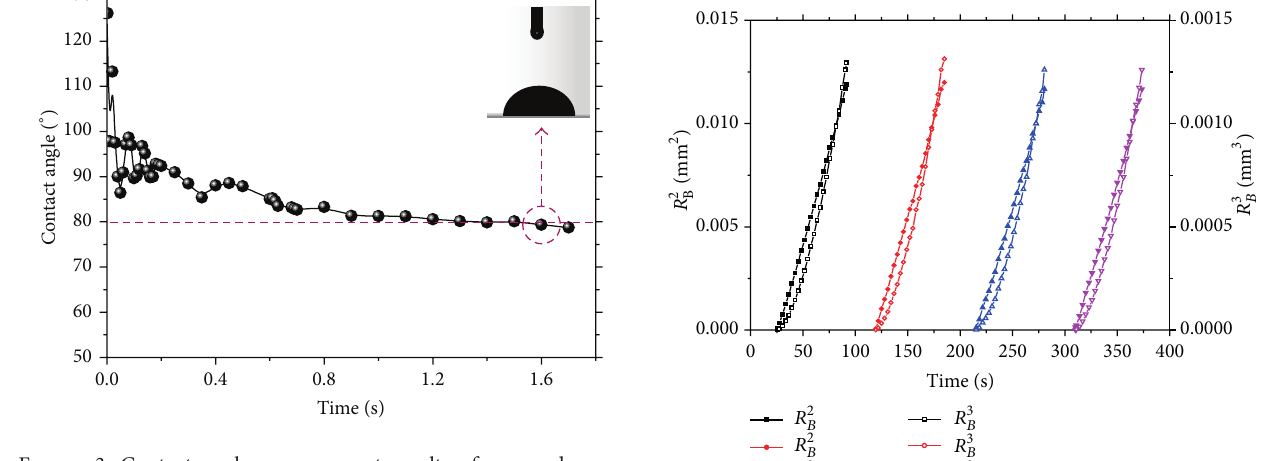
Figure 3: Contact angle measurement results of nanorod-array TiO 2 film and water.